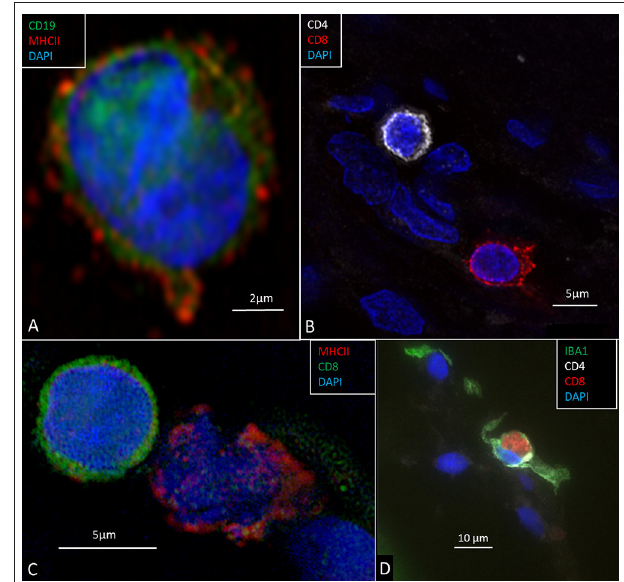
FIGURE 13 | (A) CD19-positive B lymphocyte in the modiolus. The cell also expresses MHCII. (B) CD4 and CD8-positive T cells in the peripheral region of the RC. (C) A CD8-positive lymphocyte and an MHCII-expressing cell in Rosenthal’s canal. (D) A CD8 cell is seen to physically interact with an IBA1-positive